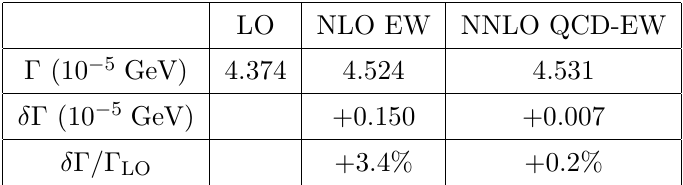
Table 2 . The partial decay widths at various orders in the G µ scheme.